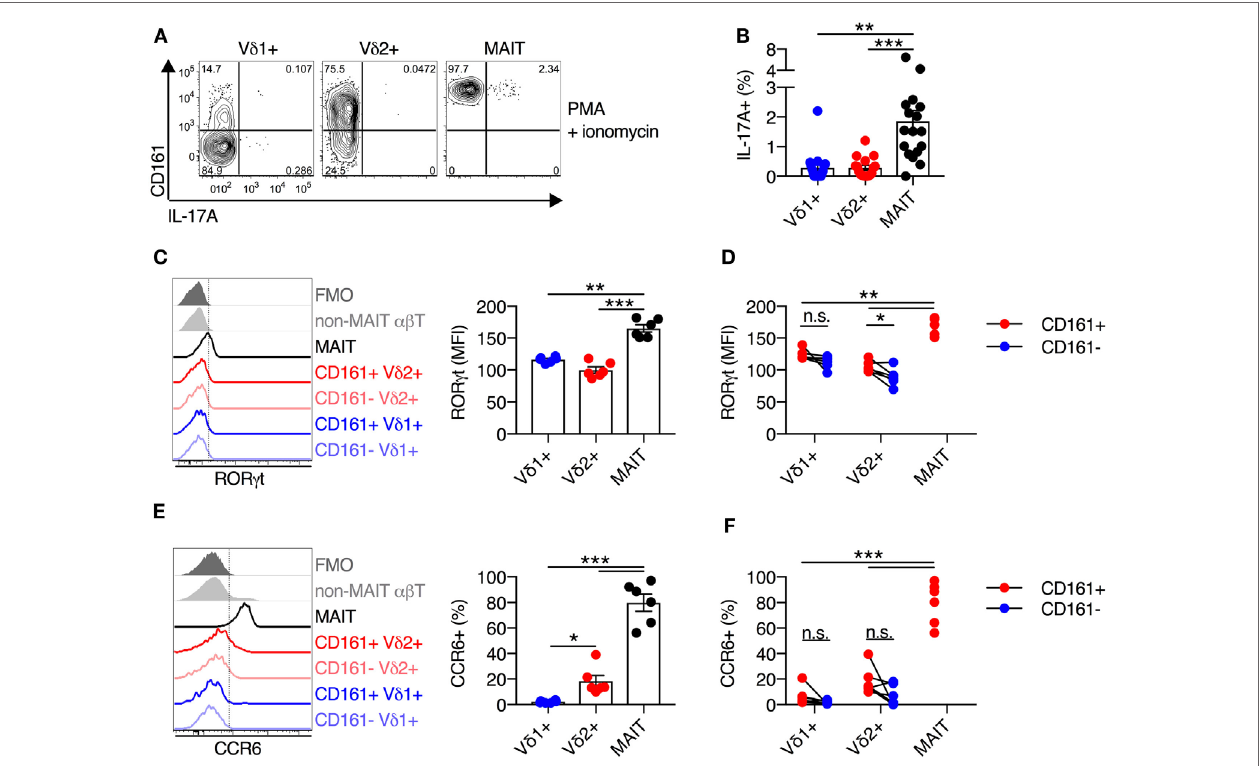
FigUre 3 | Blood V δ 2 + γδ T cells display a reduced type 17 immune phenotype compared to mucosal-associated invariant T (MAIT) cells. (a,B) Human peripheral blood mononuclear cells were stimulated for 4 h with PMA and ionomycin, and Brefeldin A and Monensin were added at the time of stimulation. Representative FACS plots (a) and group averages (B) for production of IL-17A. (c) Representative FACS plot and group averages for expression of ROR γ t. Non-MAIT αβ T cells are included as a reference population, and cells not stained with α ROR γ t antibodies (FMO) are included as a control. (D) Expression of ROR γ t segregated by CD161 expression for each cell subset. (e) Representative FACS plot and group averages for the percent expression of CCR6. Non-MAIT αβ T cells are included as a reference population, and cells not stained with α CCR6 antibodies (FMO) are included as a control. (F) Percent expression of CCR6 segregated by CD161 expression for each cell subset. Mean ± SEM. Symbols represent individual donors ( N = 6–9), representative of two independent experiments. *** P < 0.001; ** P < 0.01; * P < 0.05. Repeated measures paired ANOVA with correction for multiple comparisons (B,c,e) and paired T test (D,F)